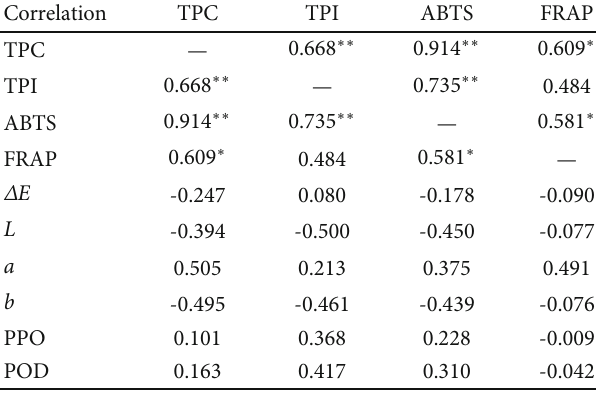
∗ Correlation is signi fi cant at the 0.05 level. ∗∗ Correlation is signi fi cant at the 0.01